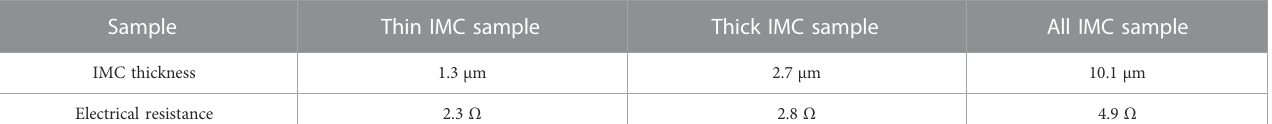
TABLE 1 The IMC thickness and electrical resistance of different samples. Sample